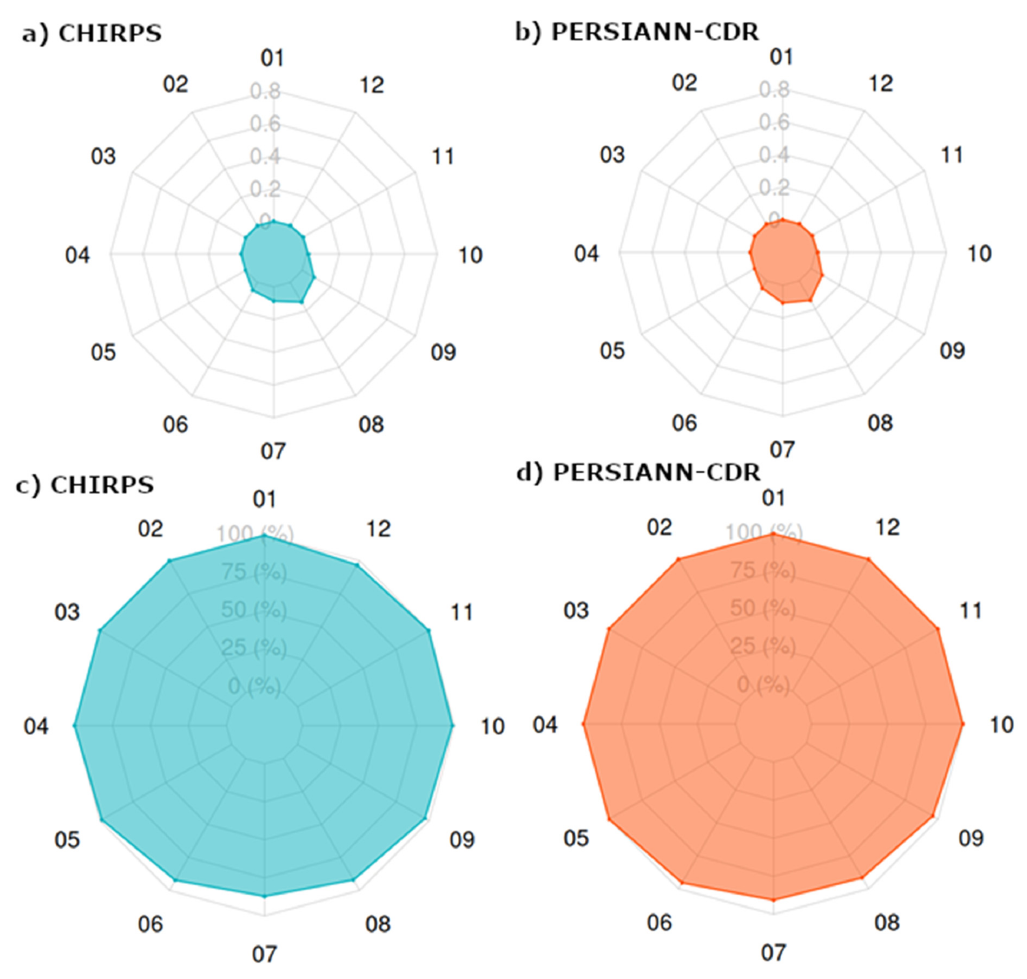
Figure 14. False alarm ( a —CHIRPS, b —PERSIANN-CDR) and probability of occurrence ( c —CHIRPS, d —PERSIANN-CDR) of the monthly rx1day (gridBR × RES) from January (01) to December (12) 1983 to 2013.